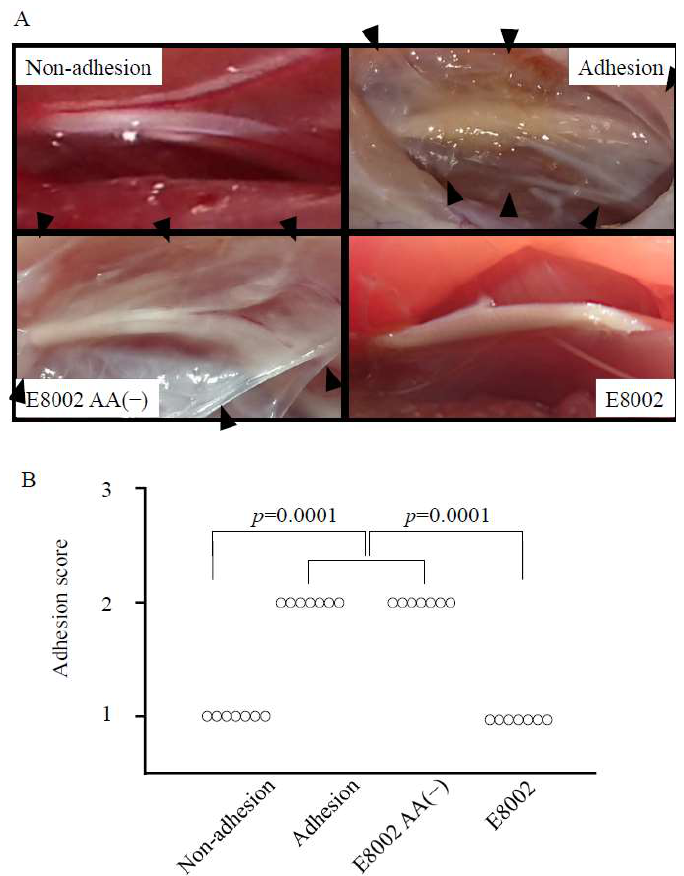
Figure 3. Effect of E8002 membrane on macroscopic peripheral nerve adhesions at 6 weeks post-surgery. ( A ) Representative photomicrographs of the macroscopic appearance of the adhesion site (adhesion, E8002(−), and E8002 groups) or related area (non-adhesion group). The tissue located in the center of each figure is the nerve tissue. The adhesion area is recognizable as fibrous connective tissue located around the nerve tissue (the white area indicated by black arrowheads). ( B ) Adhesion scores in the non-adhesion group and the E8002 group were significantly lower than those in the adhesion group and the E8002 L -ascorbic acid (AA(−)) group ( n = 7 adhesion sites or related areas per group). p = 0.001 as determined by the Kruskal–Wallis test.